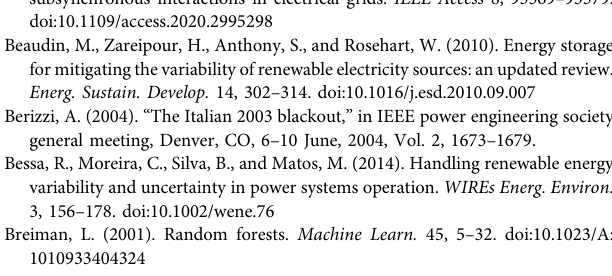
Frontiers in Energy Research |